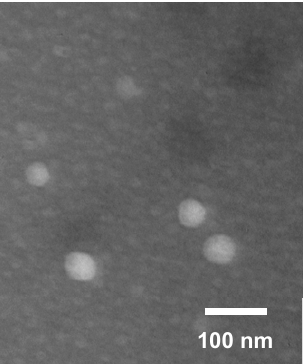
Figure 5. Transmission electron microscopy (TEM) image of paclitaxel (PTX)-loaded FA-CS-DA micelles.